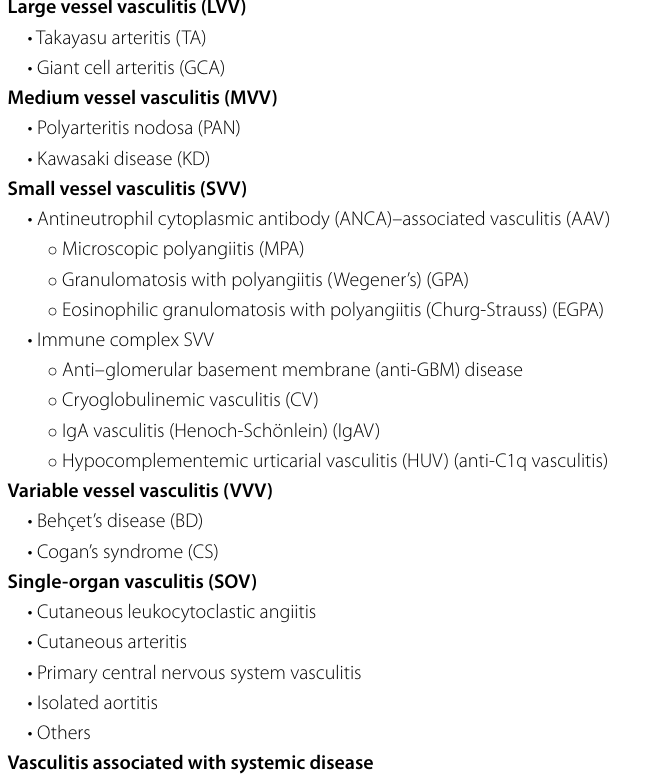
Table 1 Classification of systemic vasculitides according to CHCC nomenclature [3] Large vessel vasculitis